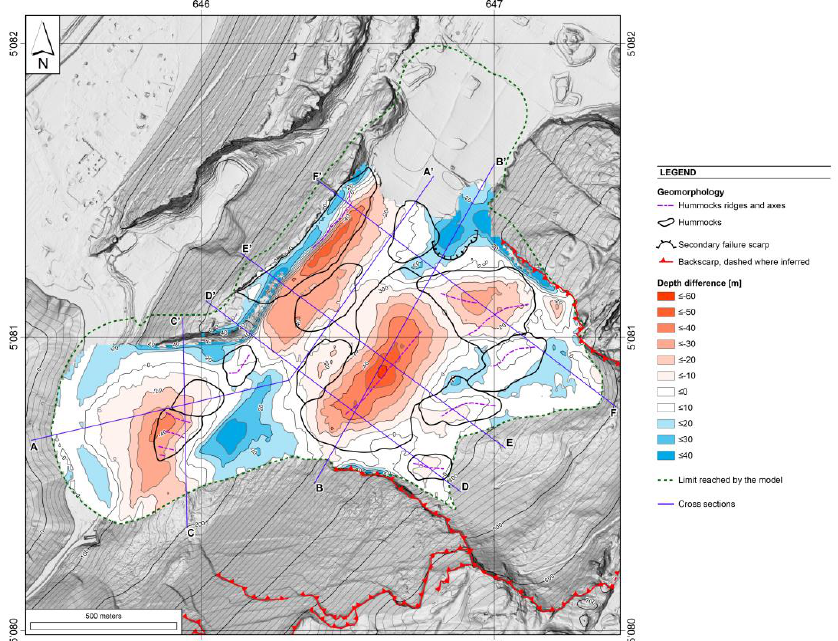
Figure 10. Map showing difference between the best-fit Voellmy parameter simulation of the landslide topography and the actual present-day topography. Negative values indicate that the simulated elevation is below the present topography. Extreme values around cliffs, as well as the part below the lake sediments, have been removed. In blue are the locations of the cross-sections shown in Figure 11.